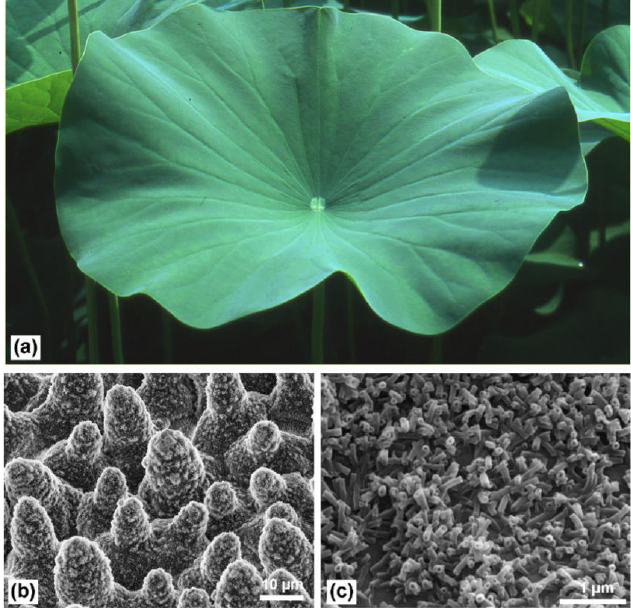
Figure 1. The superhydrophobic surface of lotus leaf; ( a ) general image of lotus leaf; ( b ) SEM image of the upper leaf side (a hierarchical surface structure consisting of papillae, wax clusters and wax tubules); ( c ) SEM image of wax clusters on the upper leaf side [7].